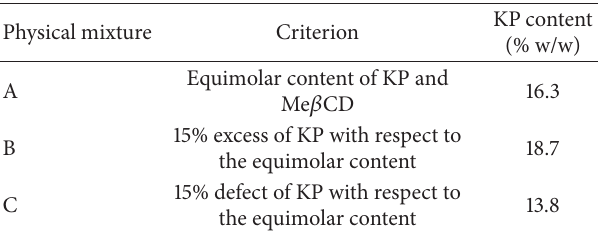
Table 1: Composition of the physical